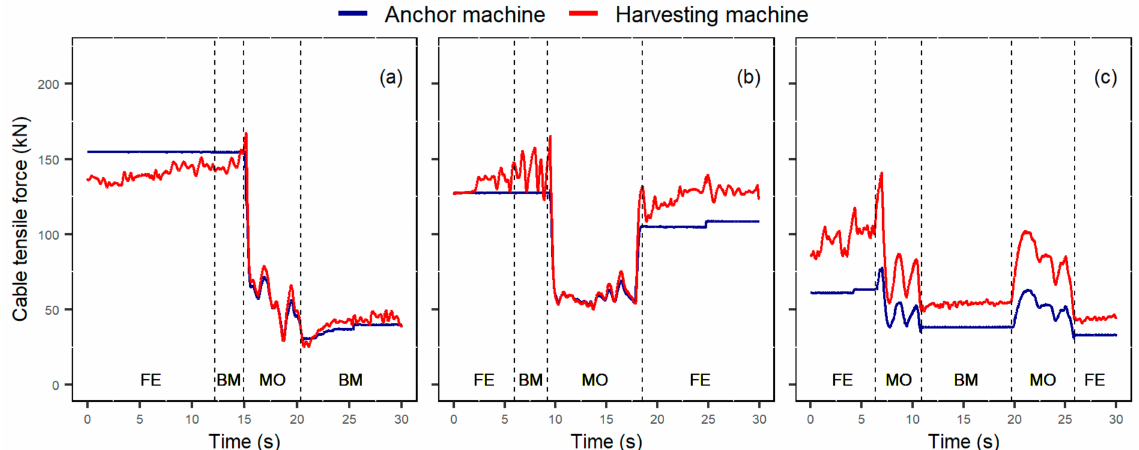
Figure 4. Example of significant events recorded during moving-out: ( a ) Typical spike-and-drop in cable tensile forces, followed by stable tensile forces around the dynamic braking; ( b ) Similar to a, but evidence of tensile force increments in the last moments of moving-out; ( c ) Evidence of tensile force increments at both the harvesting and anchor machine when the tensile forces at the anchor machine are lower than dynamic braking (note tensile forces after second 19.5). FE, felling; BM, other-boom-movements; and MO,